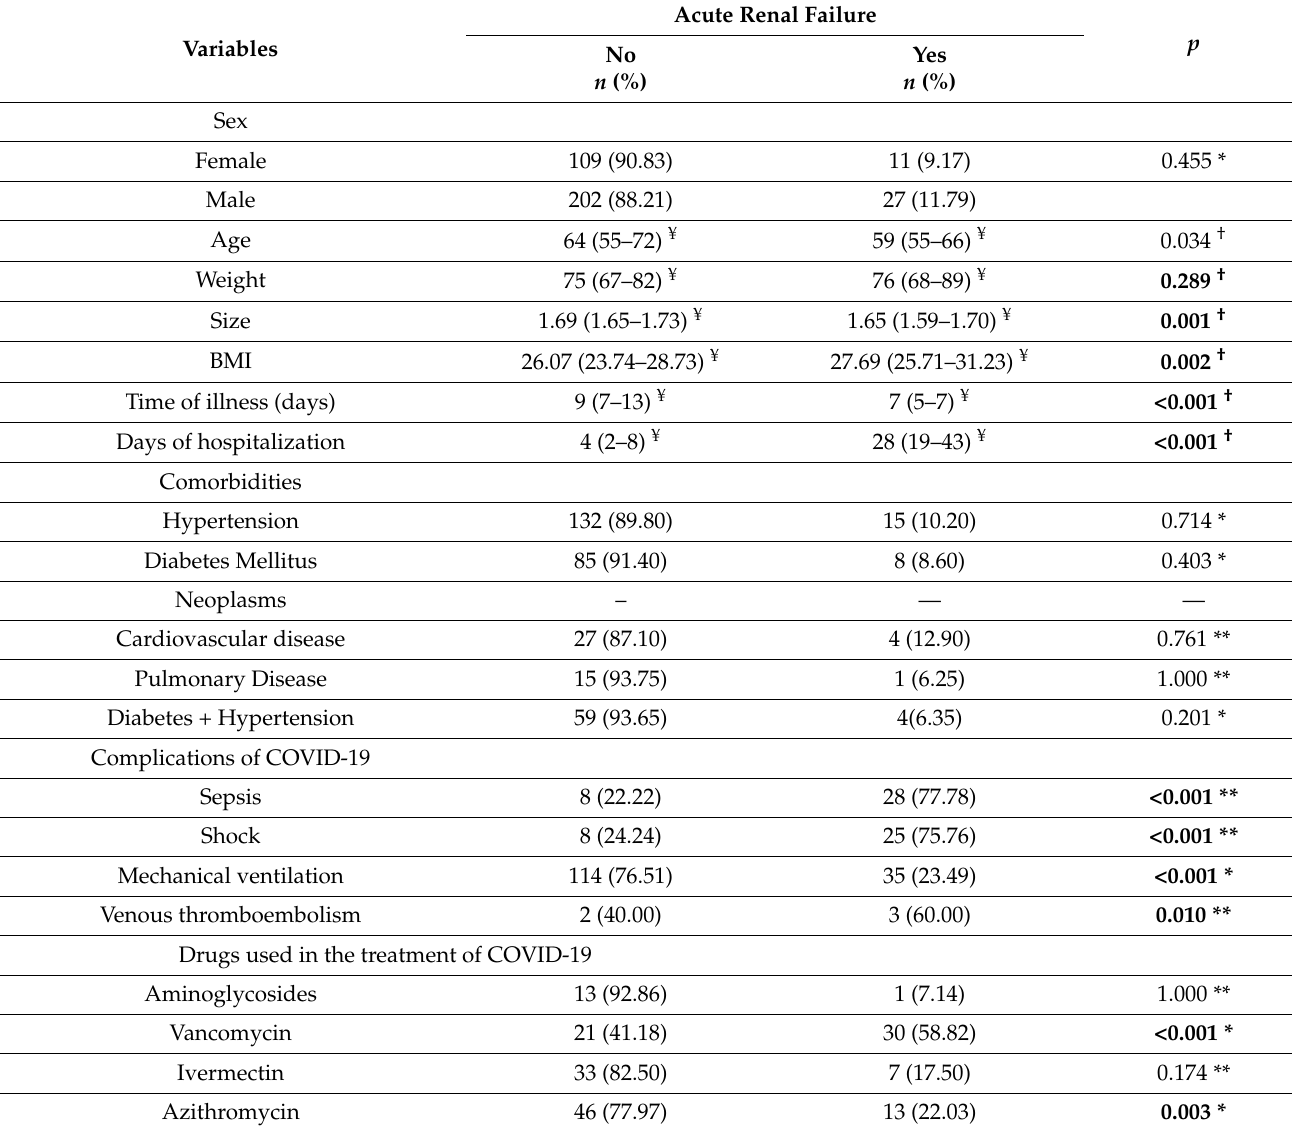
Table 2. Bivariate analysis between AKI, antibiotic use and associated factors in patients infected with SARS-CoV-2 treated at Hospital EsSalud II